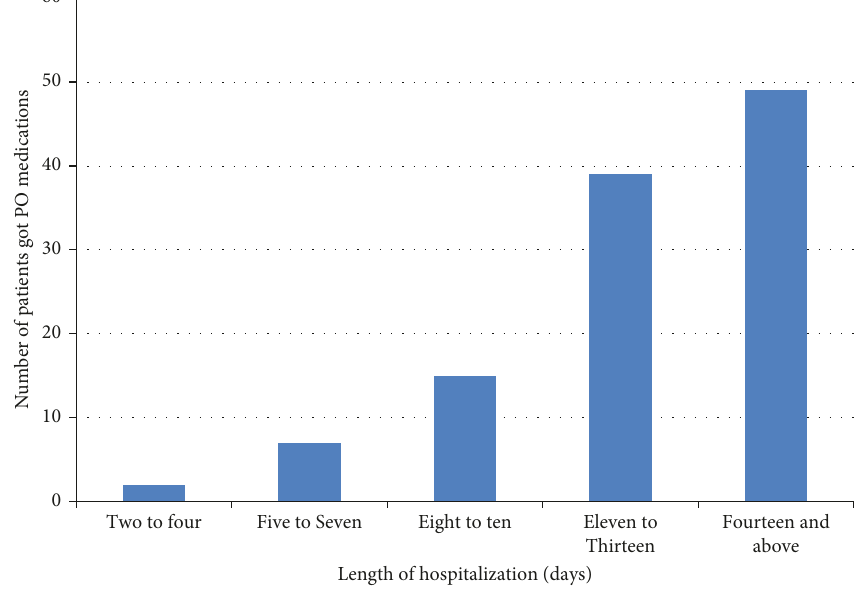
Figure 4: Percentage of IV to PO conversion based on length of hospital stay at the University of Gondar Compressive Specialized Hospital from October 3 to November 14, 2021 ( n � 324).